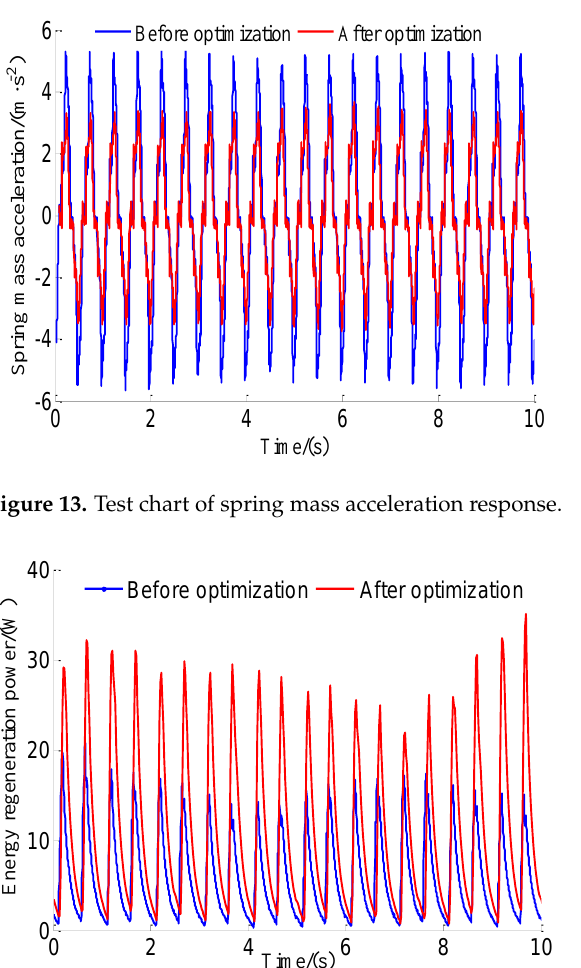
Figure 12. Bench test of EHA semi-active suspension system.